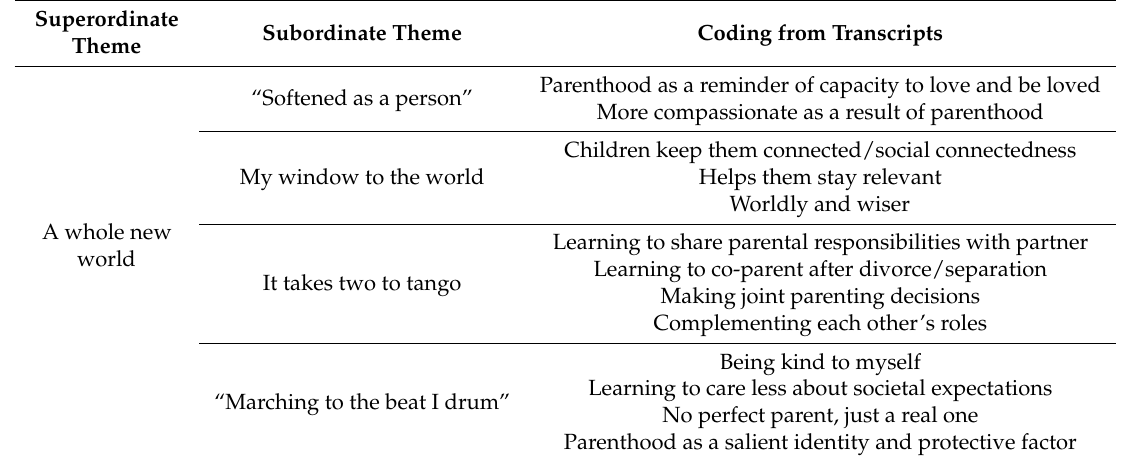
Table 3. Superordinate and subordinate themes for: ‘a whole new